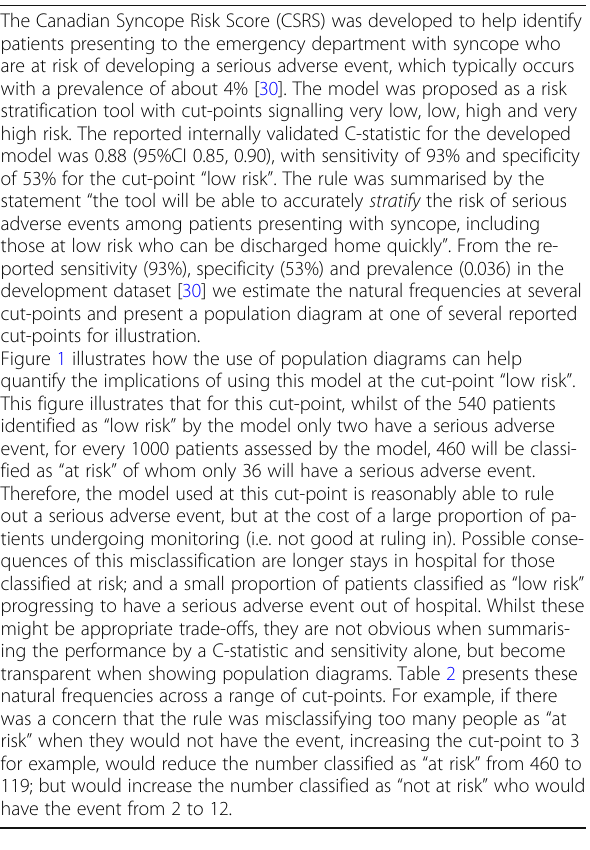
Table 1 Case Study 1 the Canadian Syncope Risk